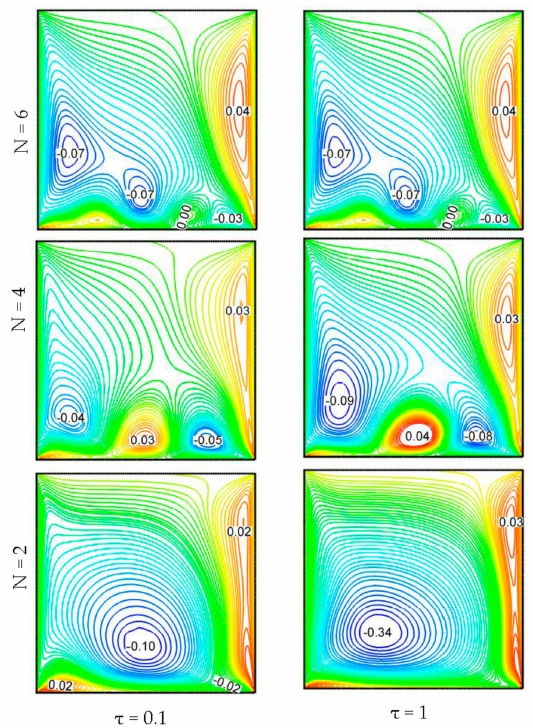
Figure 4. Influence of the even values of N on streamlines for the selected values of τ with Gr = 10 5